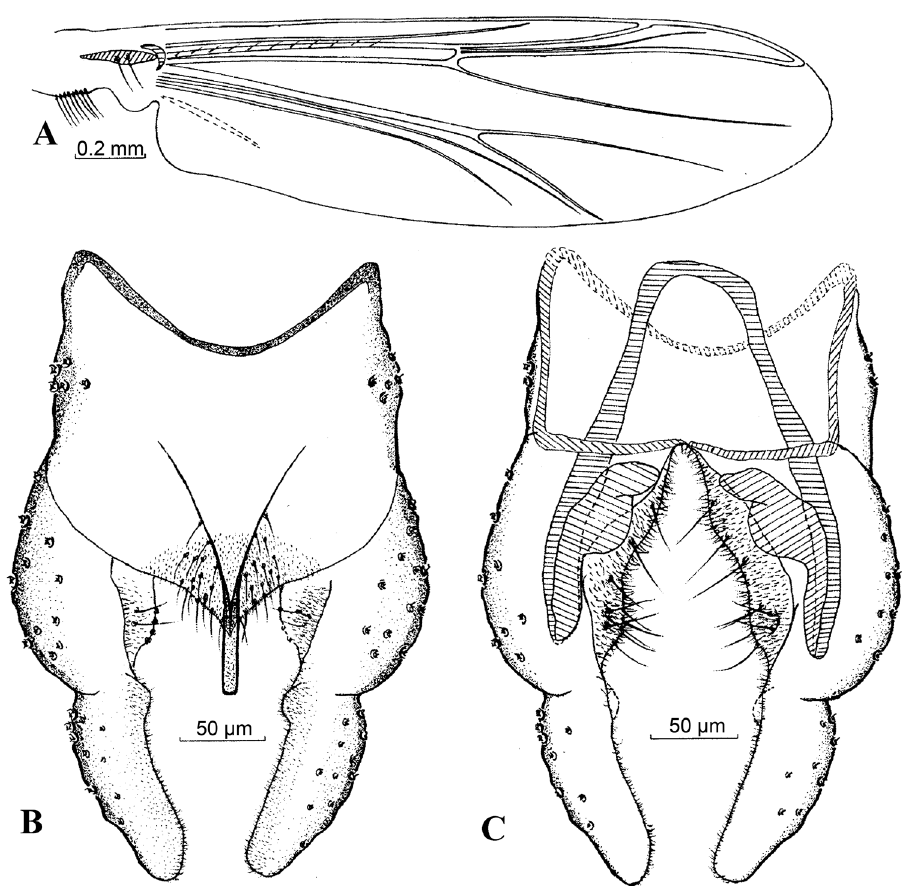
Figures 8. Harnischia parallela Yan & Wang, sp. n. A Wing; Hypopygium: B (dorsal) C